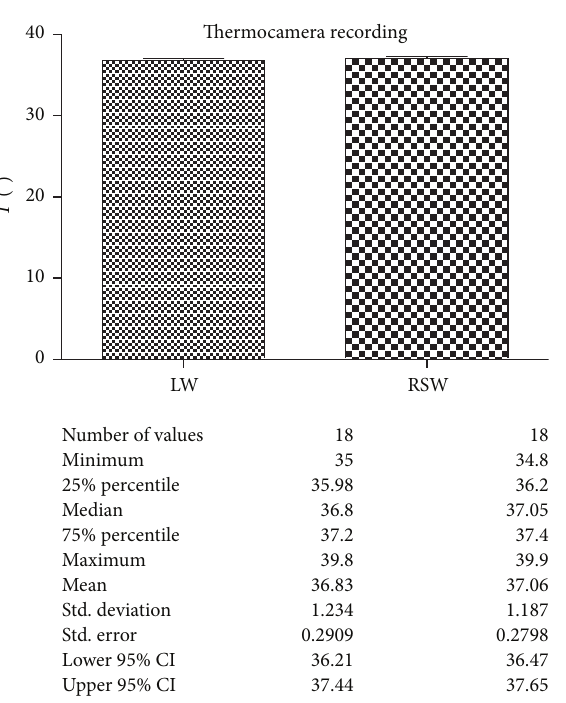
Figure 10: Comparison of the temperature in the surface recorded by thermal camera during laser welding (LW) and spot resistance welding (RSW). Description of the statistical analysis used is shown below.